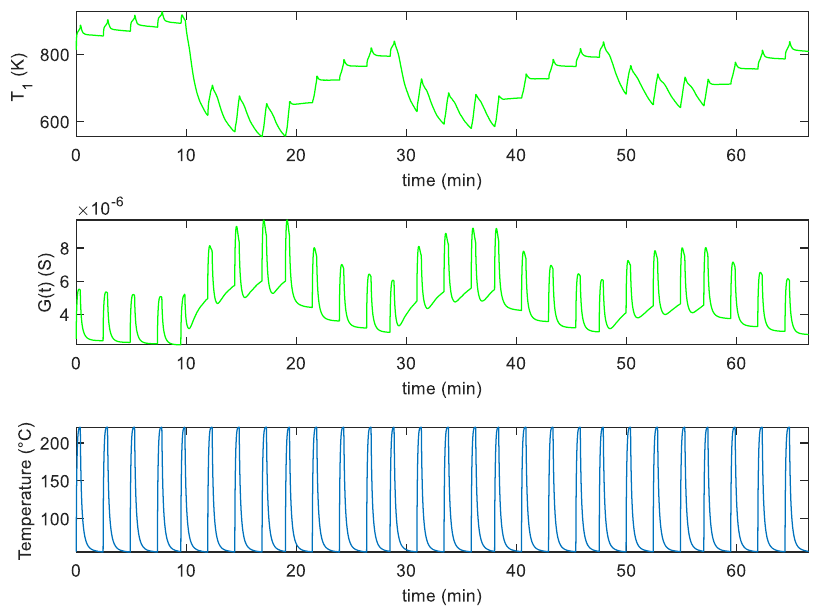
Figure 11. Measurement results for the G and T 1 as a function of time for the SWCNT-Au decorated sensor sample assuming the measurement profile as simulated in Figure 8 with an additional pure air phase preceding the NO 2 injection.